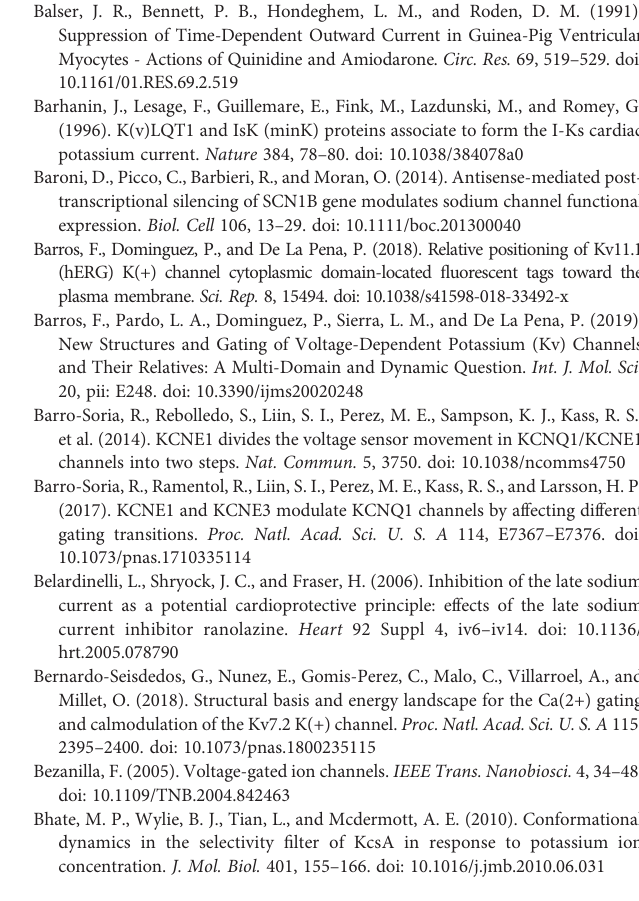
TABLE 1 | LQTS mutations in KCNQ1, hERG, and